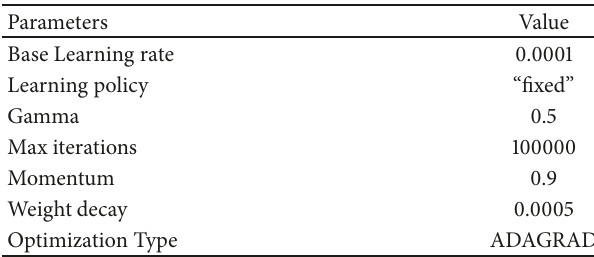
Table 1: Parameters used in our